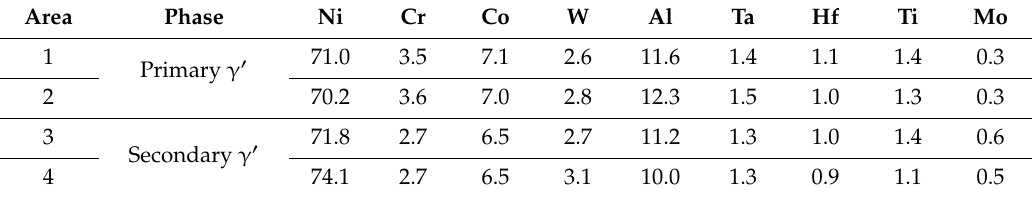
Table 6. Chemical composition of the primary and secondary γ (cid:48) precipitates in interdendritic space, STEM-EDX,